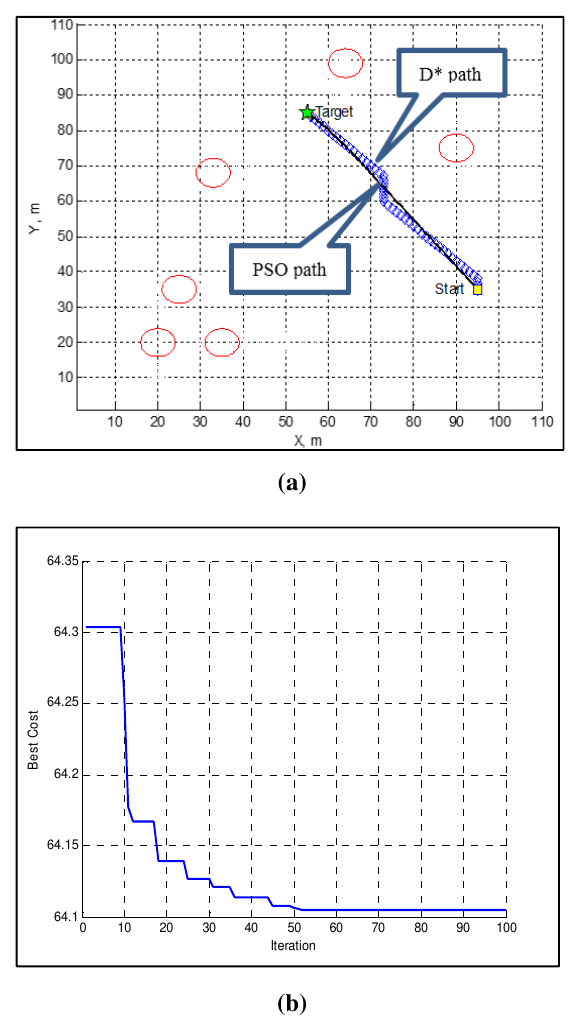
Fig. 14. (a) Represents final D* and (b) represents PSO path and the path cost function for the second